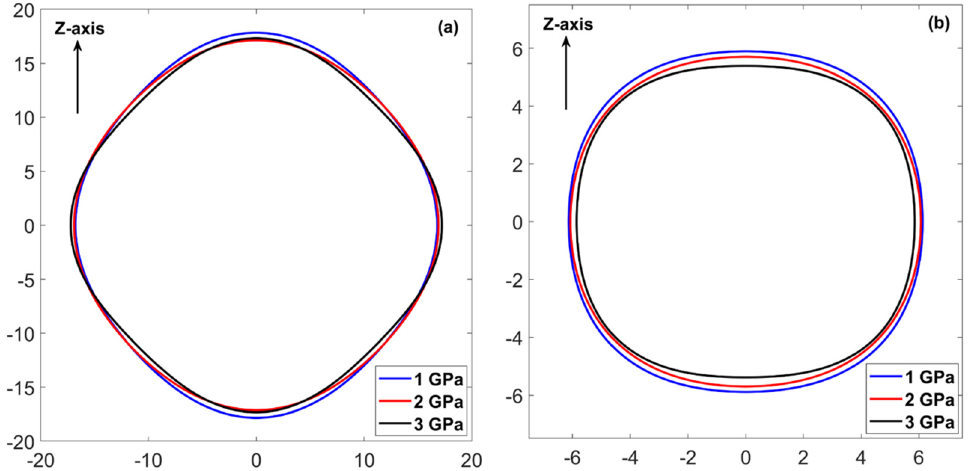
Figure 10. Polar plots of Young’s E ( a ) and shear G ( b ) moduli of empty sH gas hydrate at differ- ent pressures and 0 K. Moduli unit is